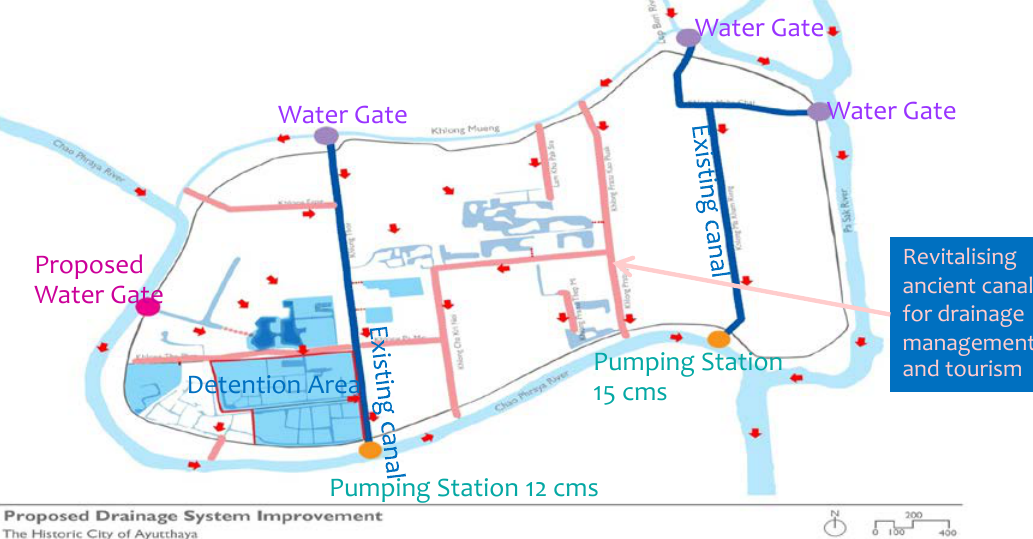
Figure 13. Final set of flood protection measures in Ayutthaya (grey infrastructure: dike, canals, pumping stations; green infrastructure: multifunctional detention and retention ponds, stormwater harvesting and reuse, productive landscapes, etc.).